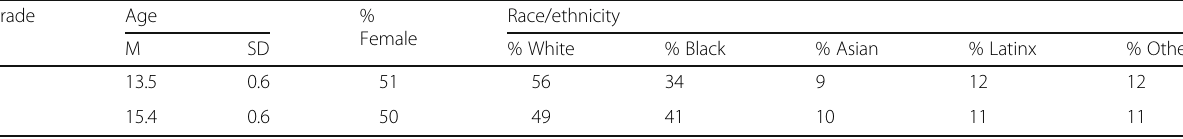
Percentages add to more than 100% due to multi-ethnic